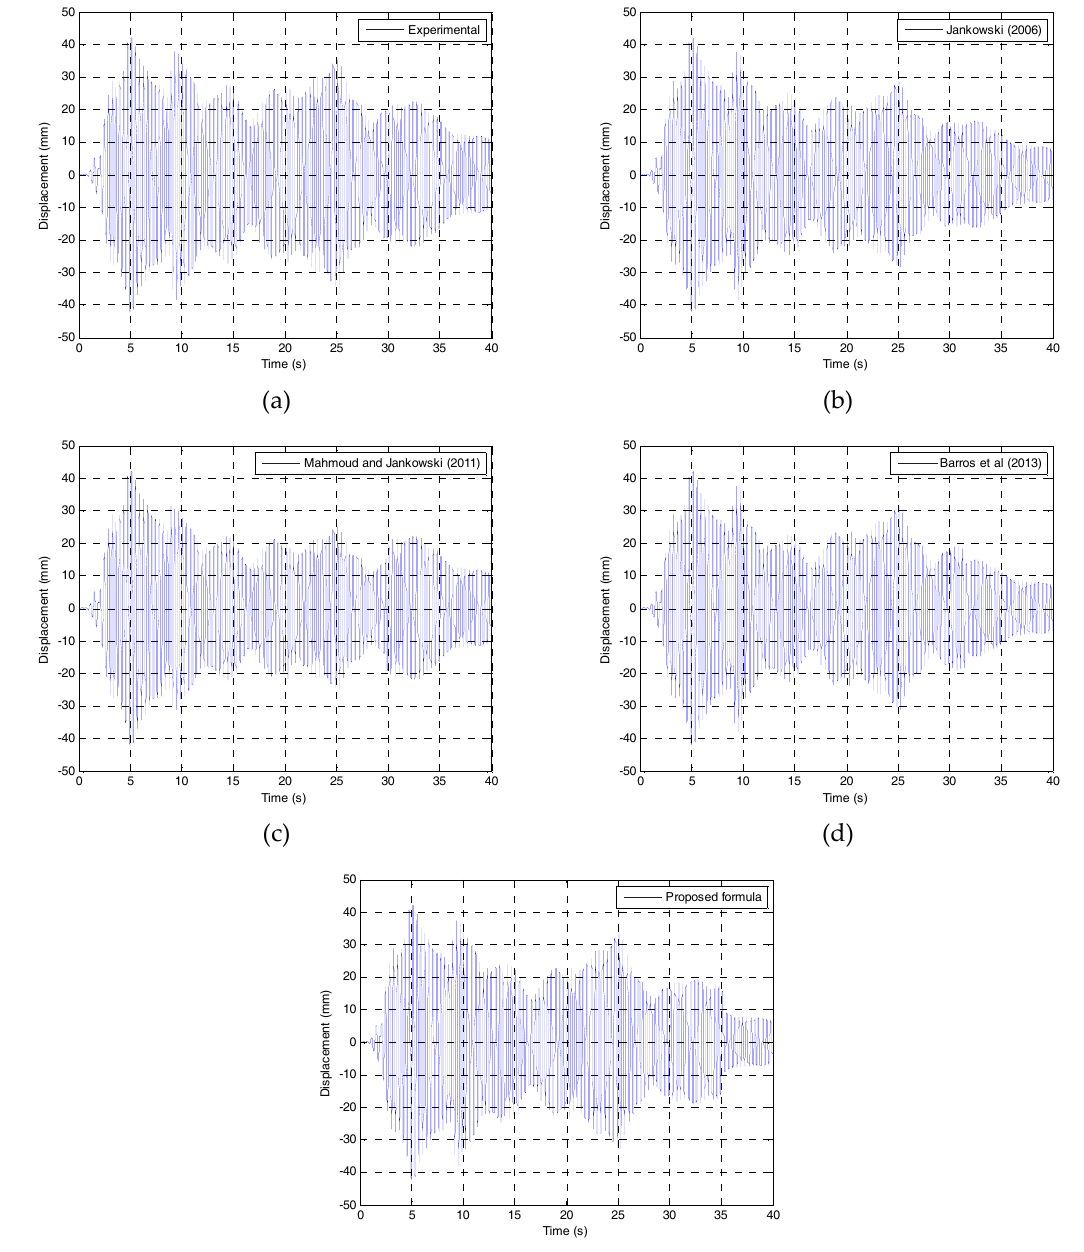
Figure 11. Displacement time histories of the left tower for pounding between two towers under the El Centro earthquake using different approaches: ( a ) experimental; ( b ) Jankowski [13]; ( c ) Mahmoud and Jankowski [15]; ( d ) Barros et al. [19] and ( e ) proposed formula. Table 3. Errors between experimental and numerical results for pounding between two structures during earthquake.